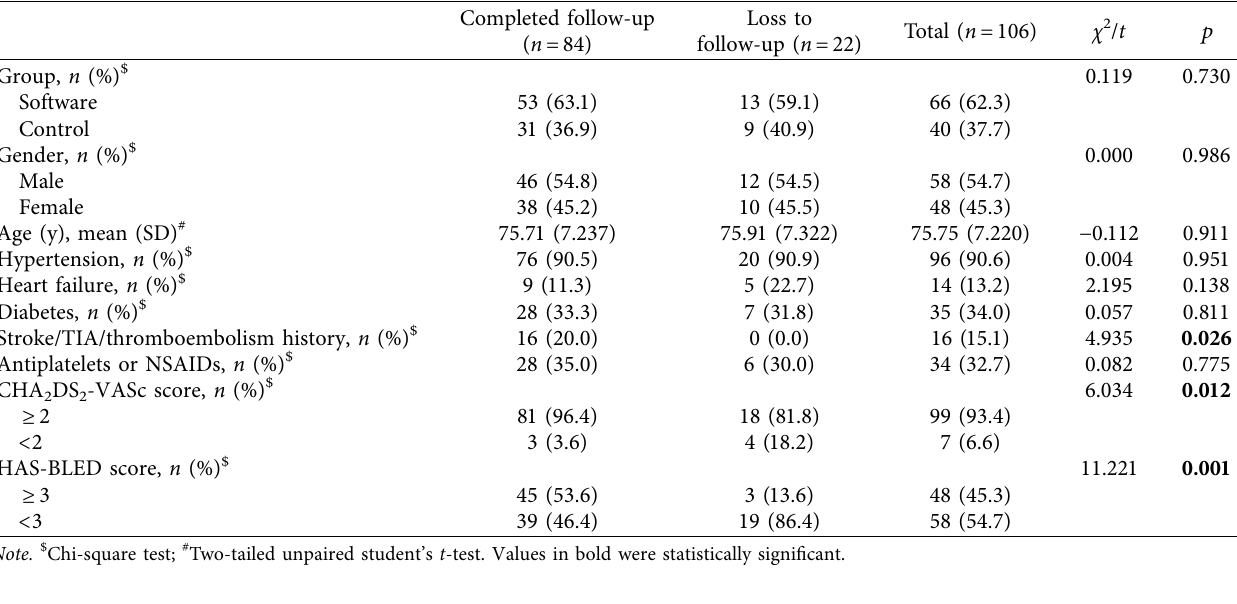
Table 3: Basic demographics of subjects lost to follow-up.